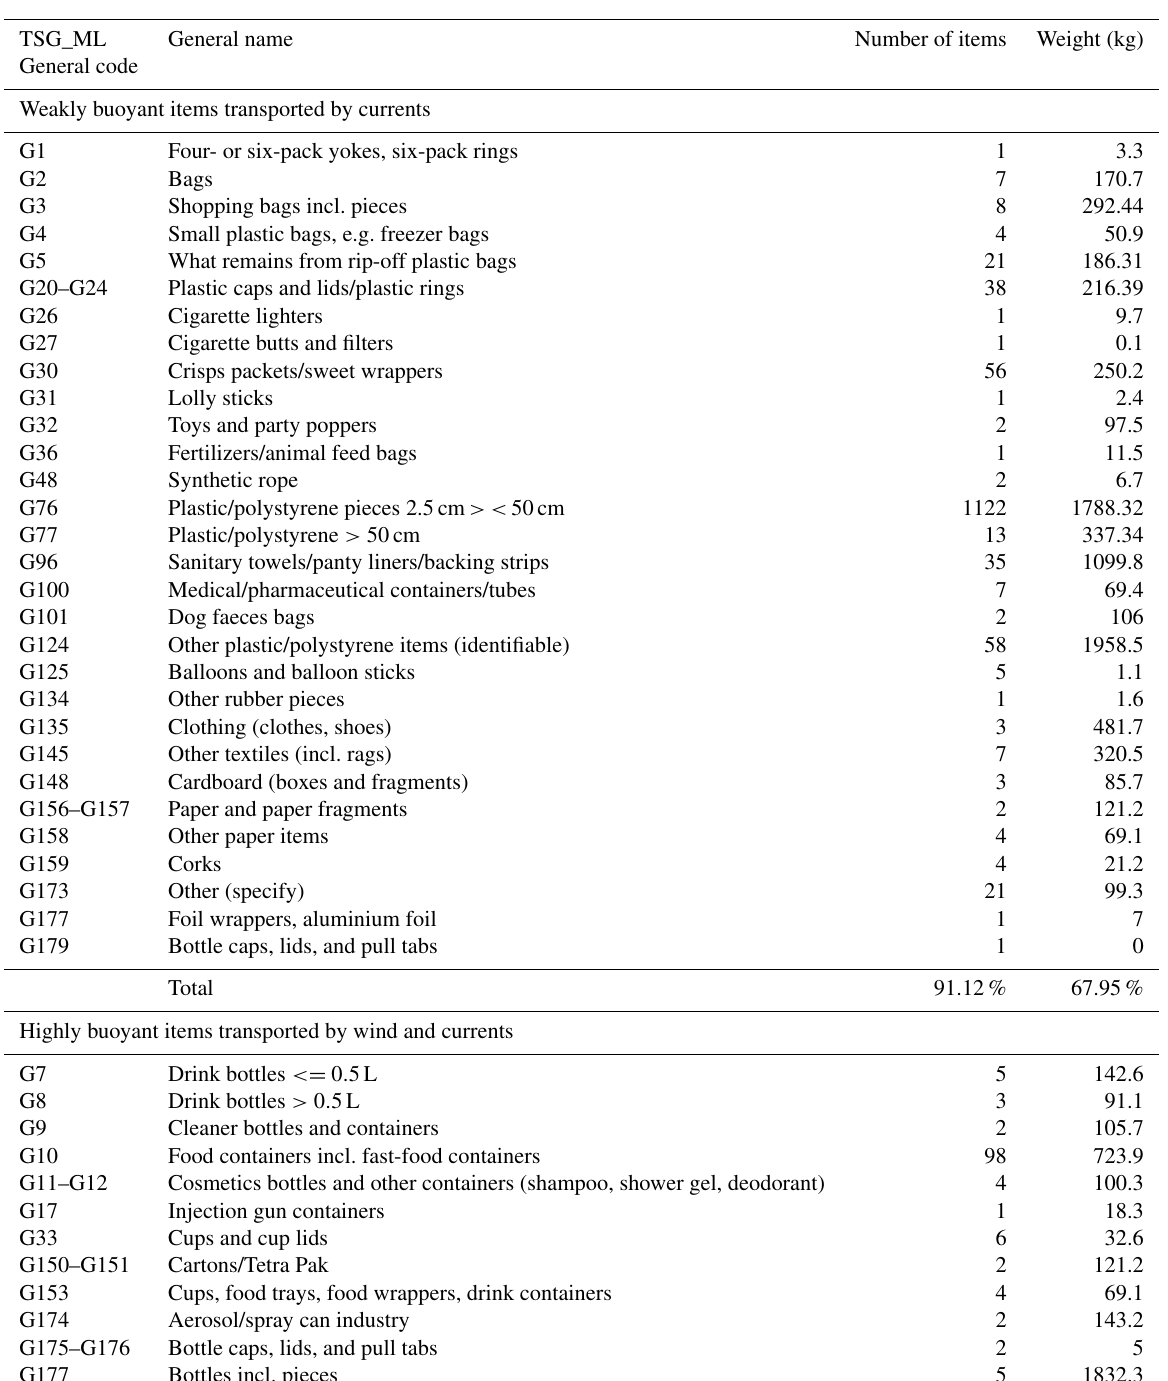
Table B1. Data were gathered from surveys carried out during spring 2018 in the Deba River